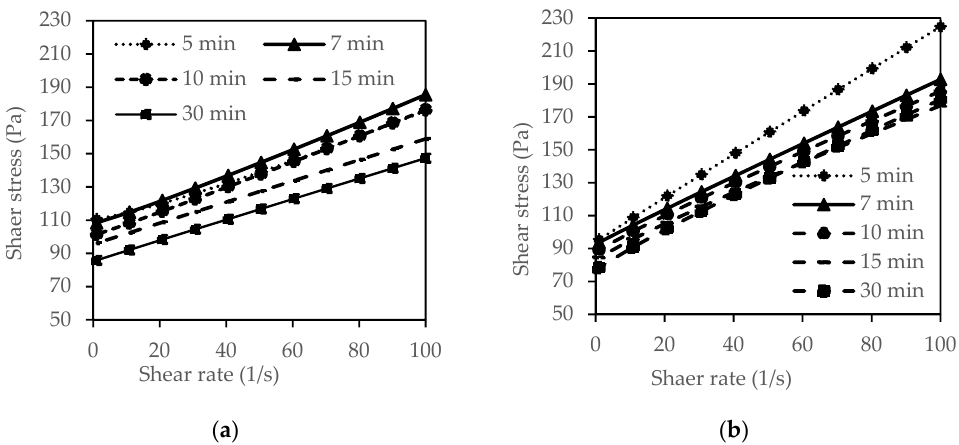
Figure 2. Effect of mixing time on the downwards flow curves of ( a ) CPB-T1 and ( b ) CPB-T2.